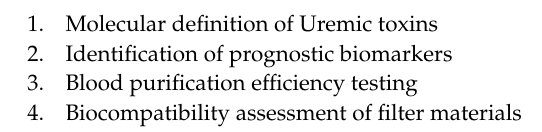
Table 1. Major investigations of Proteomics in Hemodialysis